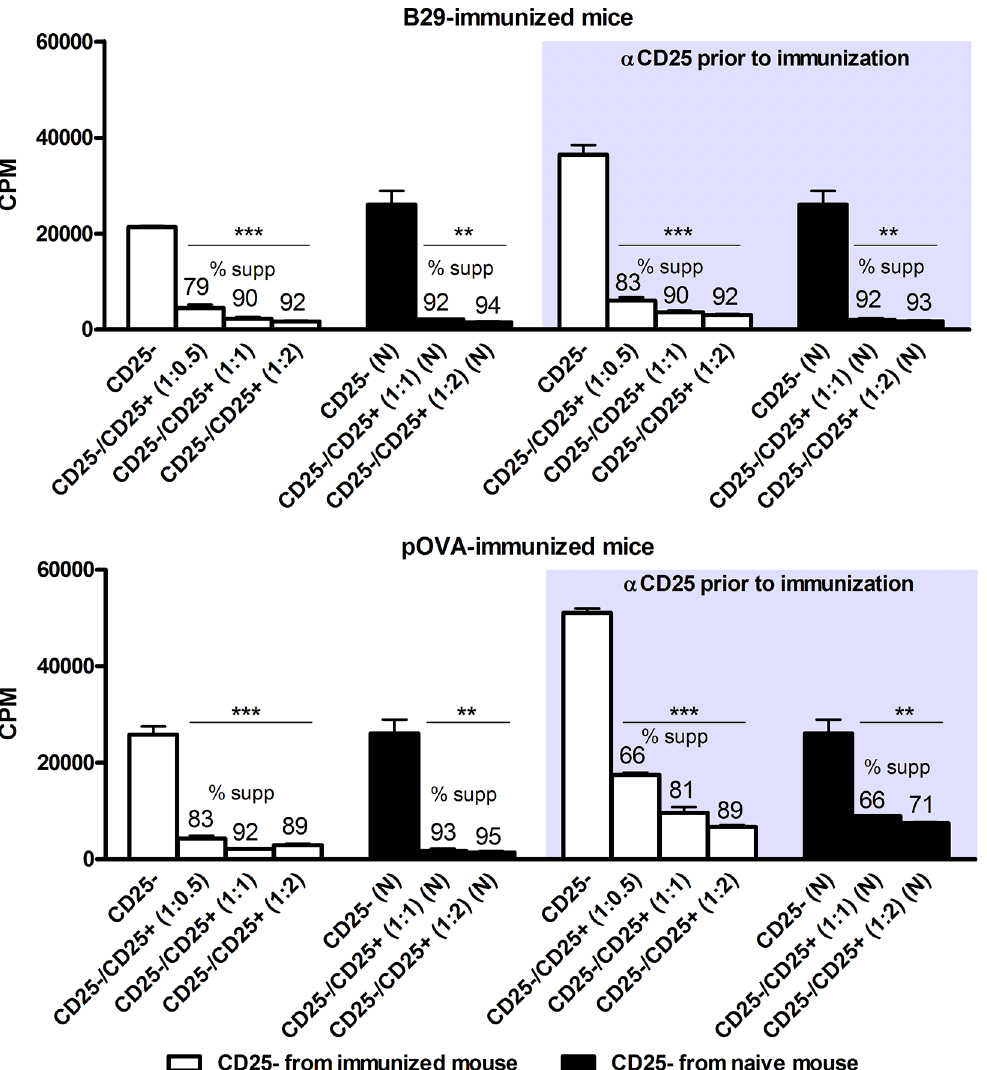
Fig 3. B29 induced Tregs are suppressive in vitro. Mice were either injected with anti-CD25 antibody to deplete CD25 + cells, or with PBS as a control. 7 days after injection, mice (n = 3 per treatment) were immunized with either B29 (upper graph) or pOVA (lower graph). 10 days later autologous CD4 + CD25 - responder cells (white bars) and CD4 + CD25 + cells were isolated and pooled for co-culture in various ratios in the presence of anti-CD3 antibody to activate the cells. As a control, also CD4 + CD25 - responder cells from na ï ve (N) donors (black bars) were used to test the suppressive capacity of B29-induced Tregs or pOVA-induced Tregs on the same population of responder T cells. 3 H-thymidine incorporation was determined and cpm data are shown as the mean of triplicate samples ( ± s.e.m.). % supp. is the proliferative response of responder T cells cultures alone, compared to responder T cells co-cultured with Tregs. Data shown are representative for two independent experiments. P values are from an unpaired two-tailed Student t-test in which cpm from CD4 + CD25 - cells were compared to cpm from CD4 + CD25 + cells. ** P < 0.01, *** P < 0.001.